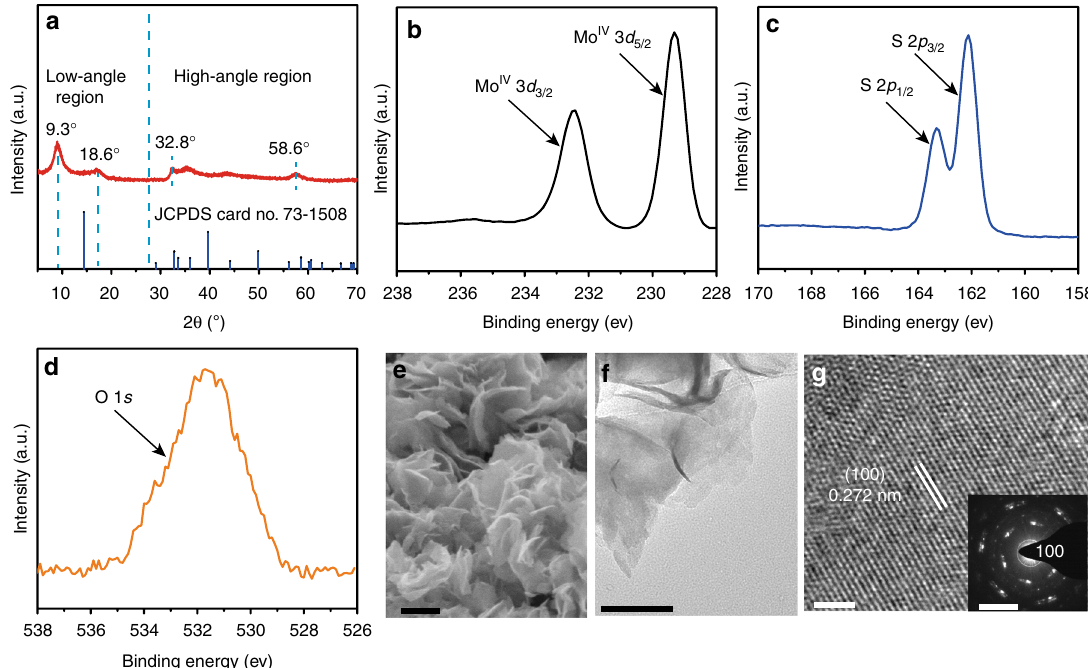
Fig. 2 Morphology and structural characterizations of the oxygen-substituted MoS 2 . a XRD pattern of the hydrothermally treated oxygen-substituted MoS 2 , and the standard pattern of the pristine 2H – MoS 2 (JCPDS No. 73-1508). XPS spectra showing the binding energies of b molybdenum, c sulfur, and d oxygen. e FE-SEM image, f TEM image, and g high-resolution TEM image of the oxygen-substituted MoS 2 . Inset of g is the selected area electron diffraction pattern of the oxygen-substituted MoS 2 . Scale bars: e 200 nm; f 100 nm; g 2 nm. Inset of g , 5 1/nm